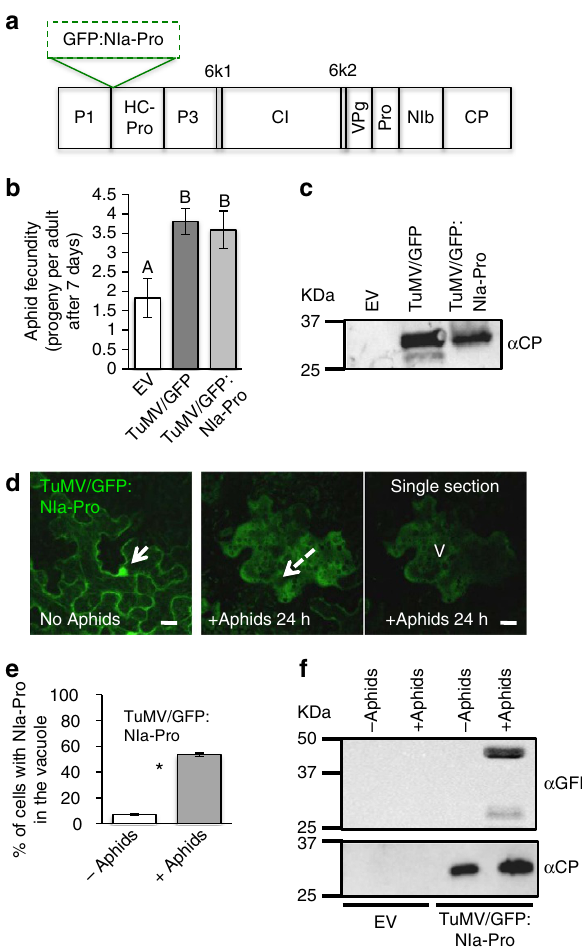
Figure 5 | NIa-Pro relocalizes to the vacuole in the presence of aphids during virus infection. ( a ) Schematic representation of the recombinant TuMV-expressing GFP:NIa-Pro. Each rectangle represents individual proteins of the TuMV polyprotein. ( b ) Number of progeny produced by aphids on N. benthamiana infiltrated with empty agrobacterium (EV), TuMV/GFP or TuMV/GFP:NIa-Pro. ( c ) The image depicts a western blot from leaf extracts expressing empty vector (EV), TuMV/GFP and TuMV/ GFP:NIa-Pro incubated with an antibody that binds to the coat protein (CP) of TuMV. ( d ) Images show confocal projection and a single section (on the right) of N. benthamiana leaves agroinfiltrated with TuMV/GFP:NIa-Pro with or without aphids for 24h. GFP:NIa-Pro relocalizes from the nucleus (white arrow) to the vacuole (V, dashed arrow) in the presence of aphids. ( e ) The percentage of cells with GFP in the vacuole for N. benthamiana infected with TuMV/GFP:NIa-Pro with and without aphids. ( f ) The image represents a western blot from vacuole purification derived from leaves expressing EVor TuMV/GFP:NIa-Pro before or after aphid presence and incubated with a GFP antibody and an anti TuMV-CP antibody. The western blot shows that GFP is only visible in the vacuoles from leaves expressing TuMV/GFP:NIa- Pro and after aphid presence. (mean ± s.e. of N ¼ 12–20 for b and N ¼ 6 for e ; letters and stars represent significant differences, ANOVA and Tukey’s honest significant difference post hoc for b or Student’s t- test for e , P o 0.05). Scale bars, 20 m m.